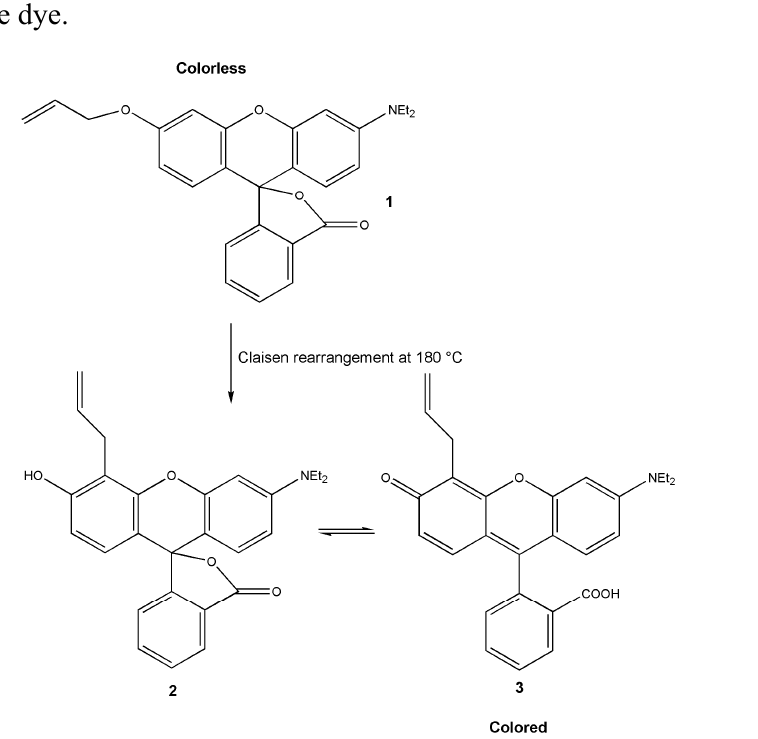
Figure 6. Claisen rearrangement and intramolecular acid-base reaction in a thermoresponsive dye.